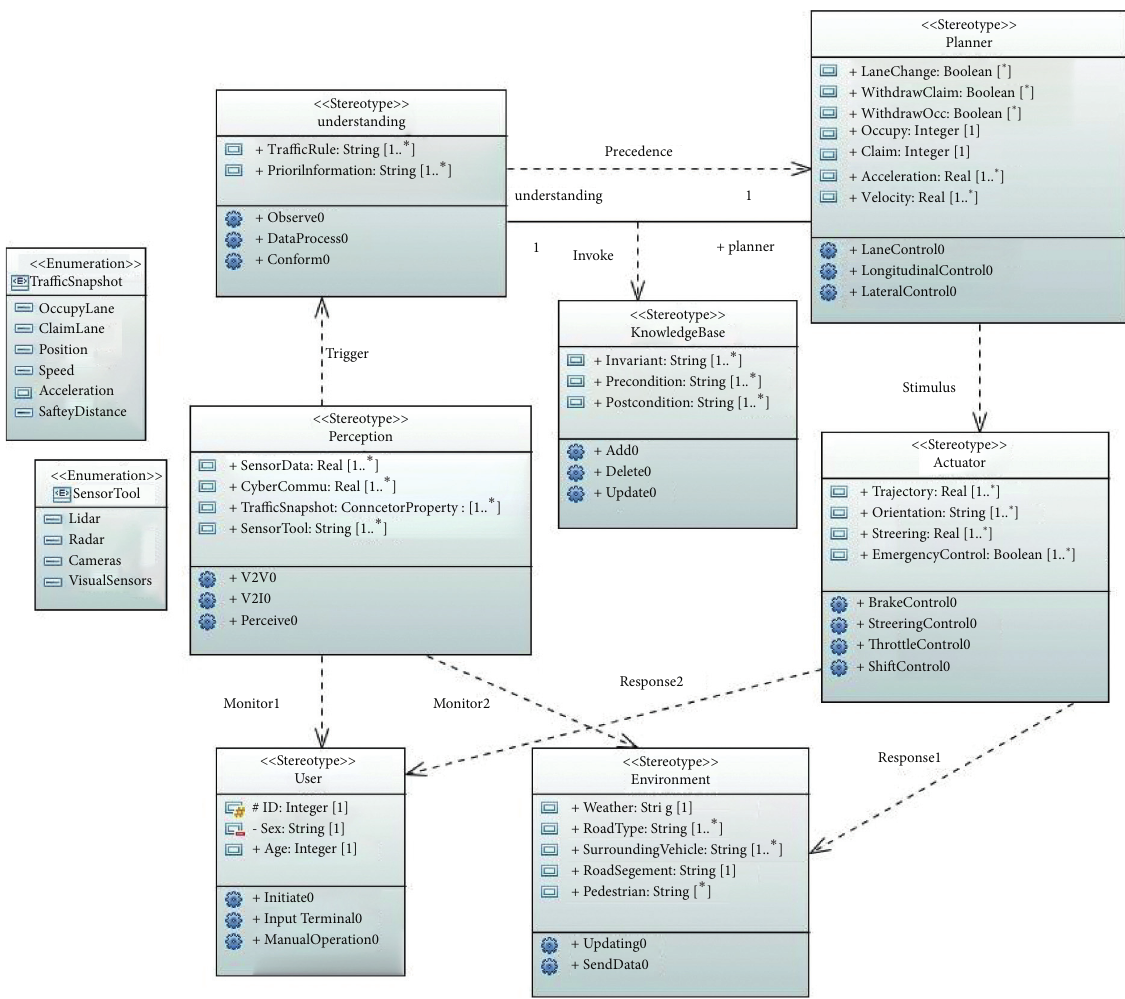
Figure 7: SysML profile for autonomous driving system architecture. Table 3: Semantic interpretation of relationship in autonomous